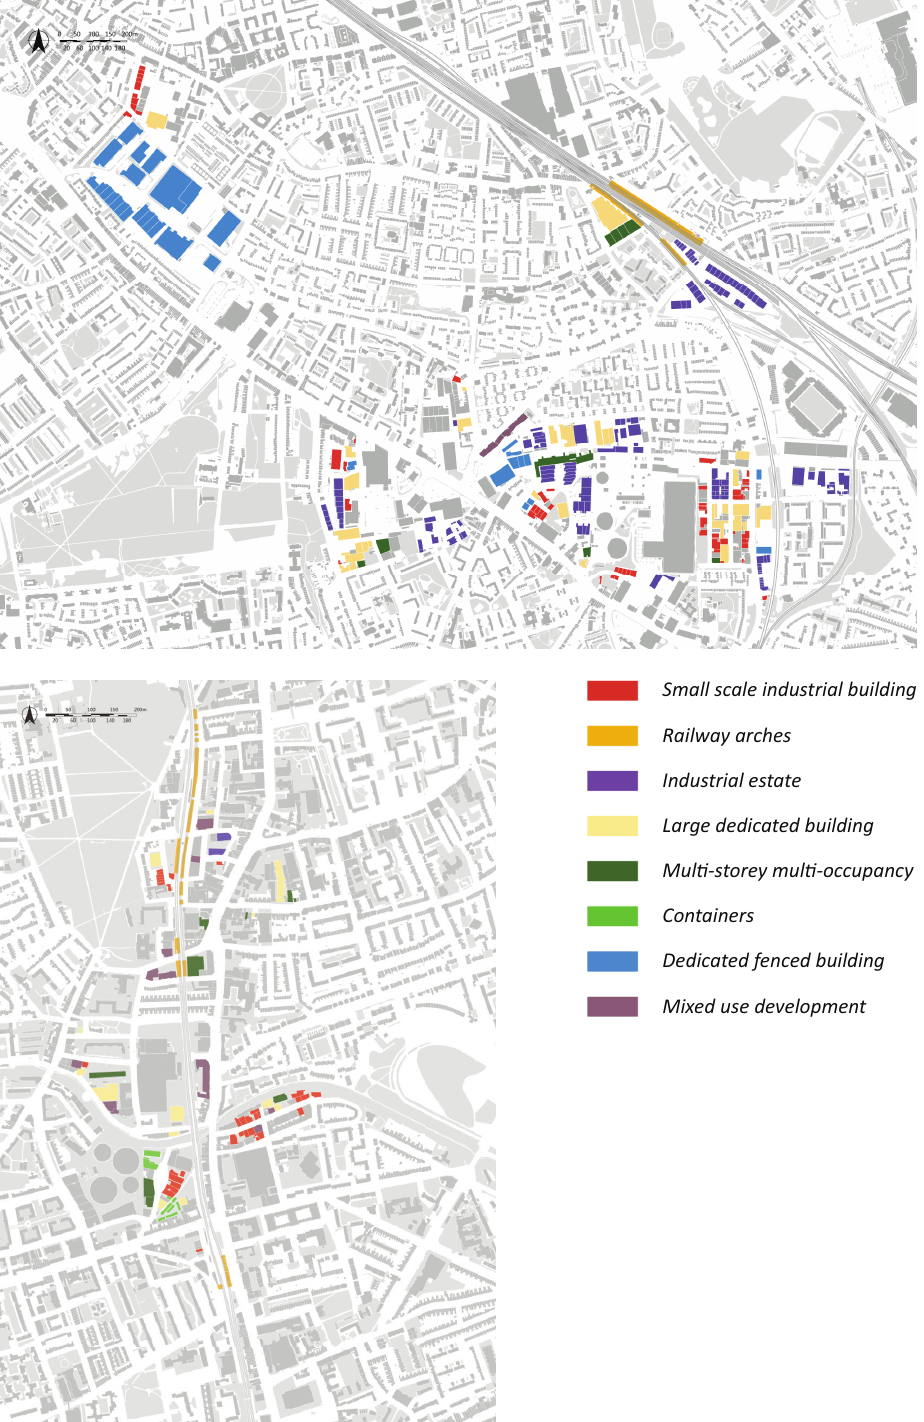
Figure 8. Maps of the Old Kent Road (top) and Hackney Mare Street (bottom) highlighting the geographical distri‐ bution of industrial building types, based on site observations. Base map source: Ordnance Survey (2019).